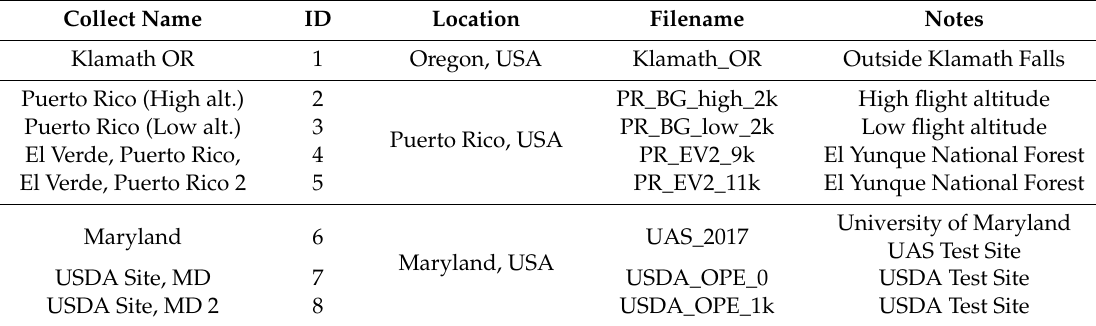
Table A2. In-flight acquisitions used in this